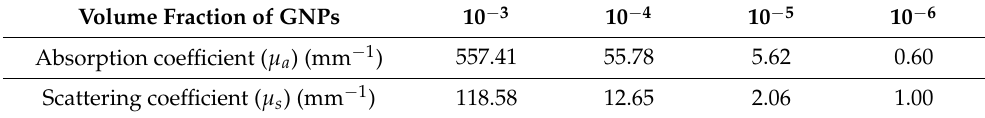
Table 3. Optical properties of the tumor with GNPs for the changing volume